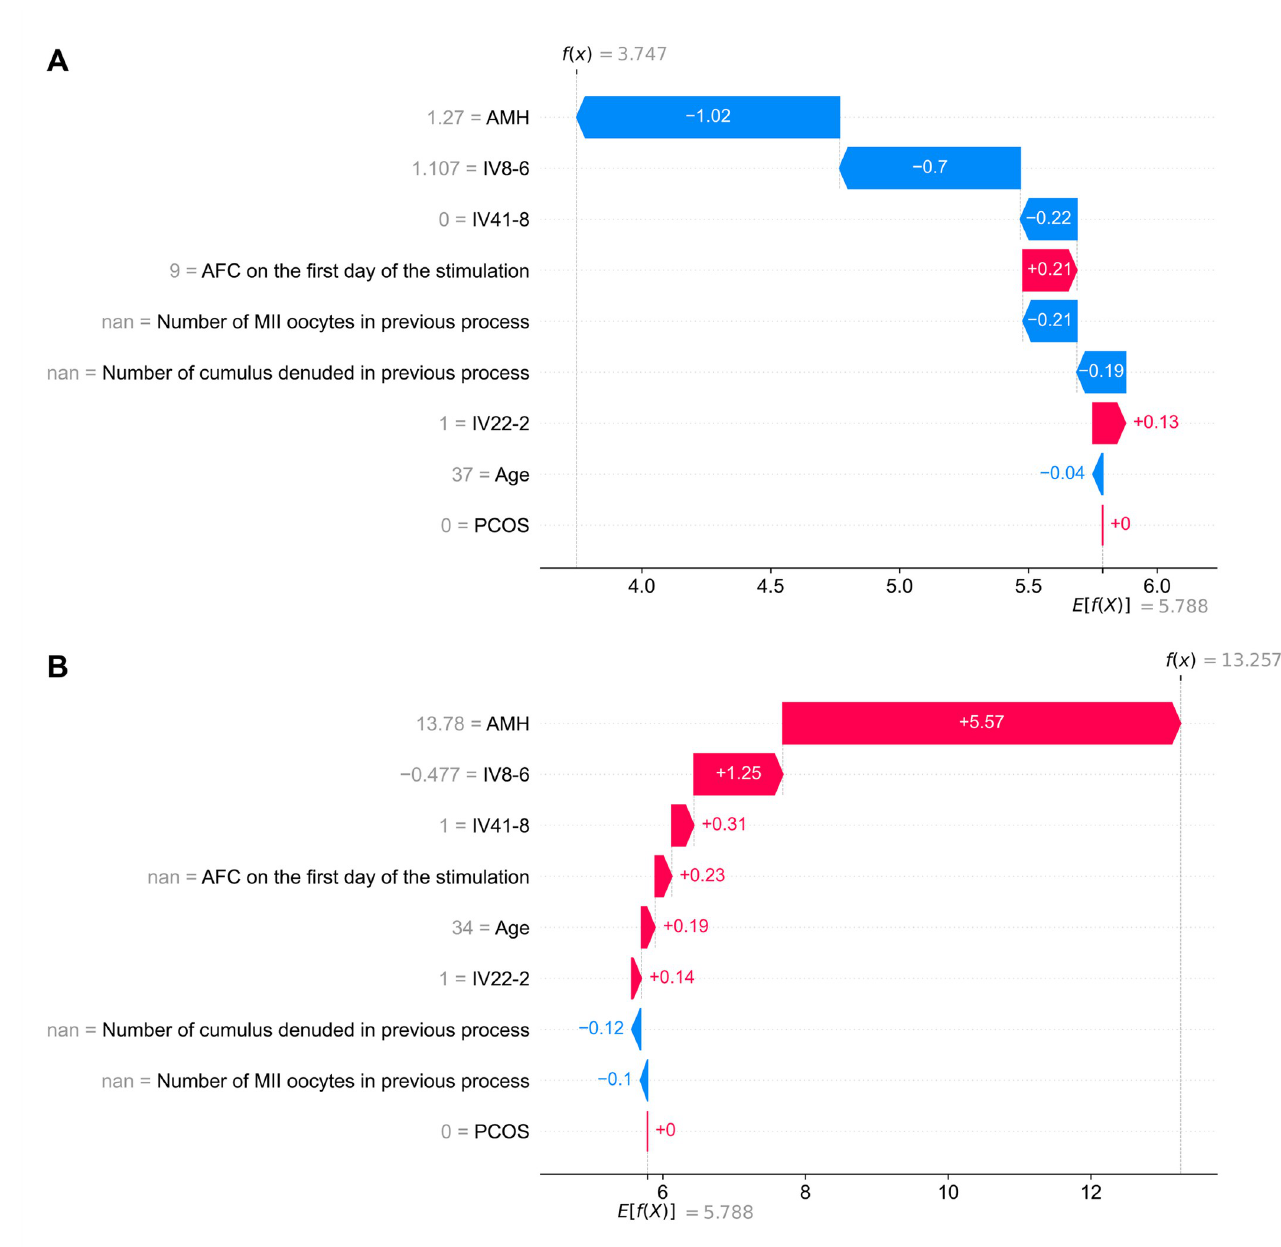
Fig 3. Interpretation of two examples of personalized predictions of the number of MII oocytes. The effect of all features used in the clinical-genetic predictive model on the predictions of the number of MII oocytes was estimated retrospectively for ( A ) Patient 1 and ( B ) Patient 2. The x-axis shows the number of MII oocytes, and the y-axis shows the included features. The arrows indicate the contribution of each feature to the final prediction f ( x ) obtained for a patient; red and blue indicate an increase or decrease in the predicted number of MII oocytes by the factor, respectively. A detailed interpretation of both cases is provided in the text. AFC—antral follicle count; AMH—anti-Mu¨llerian hormone; nan—not a number; PCOS—polycystic ovary